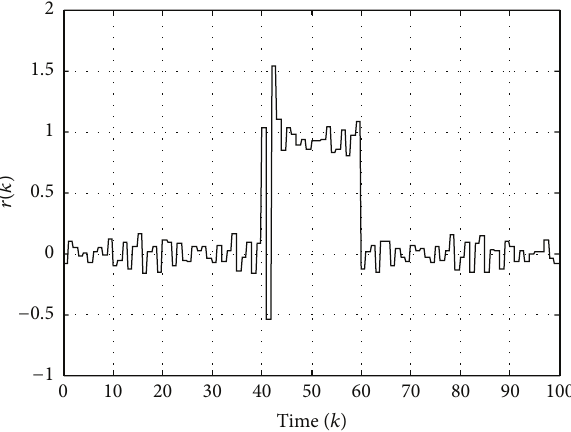
Figure 6: Residual signal 𝑟(𝑘) when 𝜌 = 0.9 and 𝐷 𝑓 (𝑘) = 1.8 .